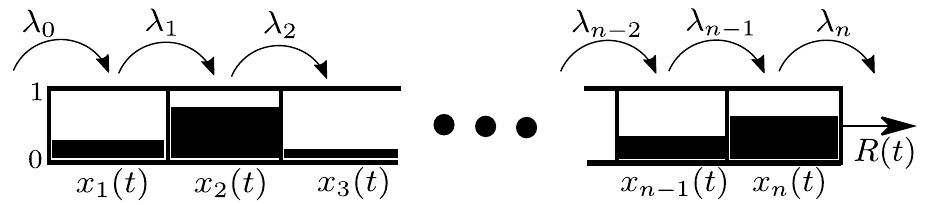
0, 1 represents the normalized ∈ [ ] 1 , with (cid:31) 0 [ (cid:31) n ] +